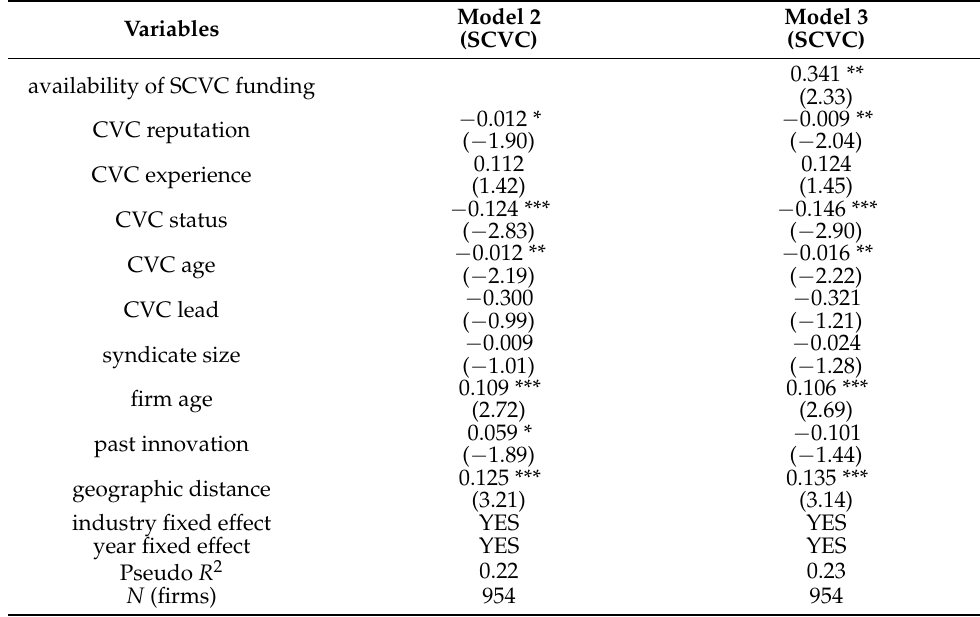
Table 4. First-stage Probit model: the likelihood of a firm receiving SCVC